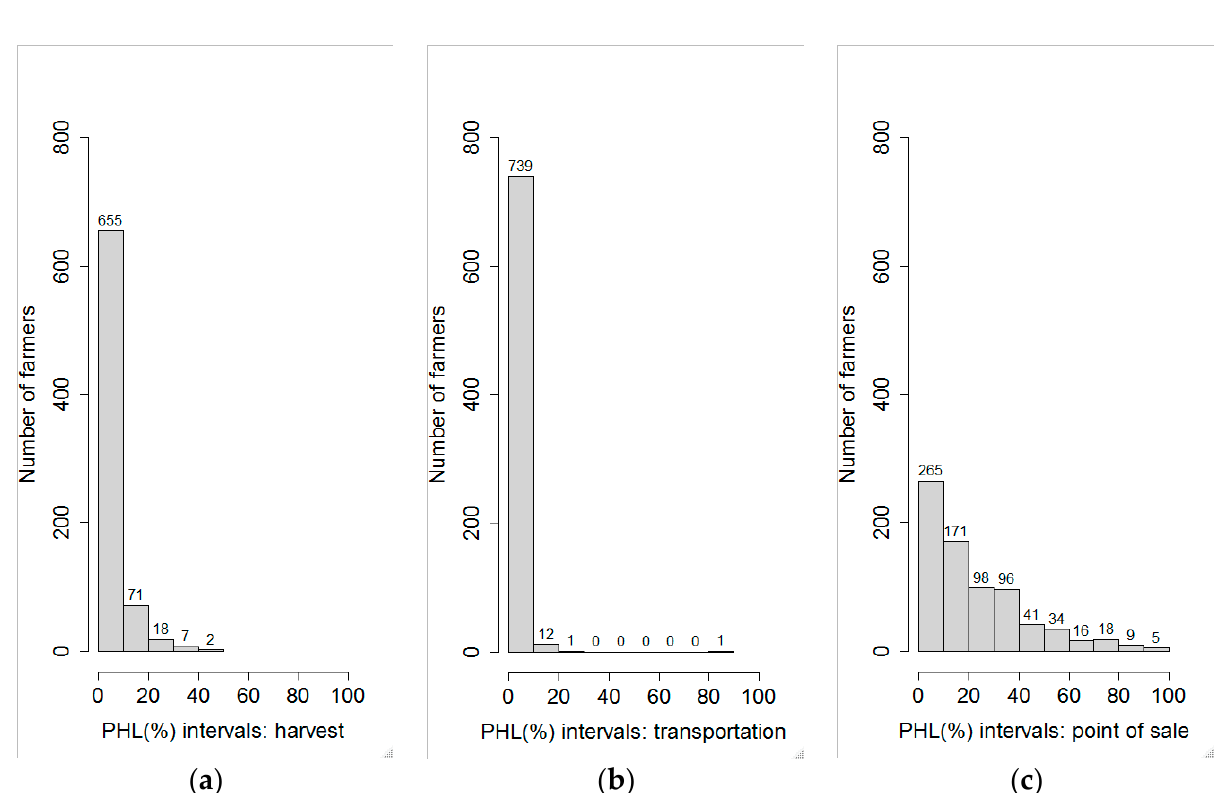
Figure 1. Distributions of mango PHL (%) during harvest ( a ), transportation ( b ), and at point of sale ( c ).